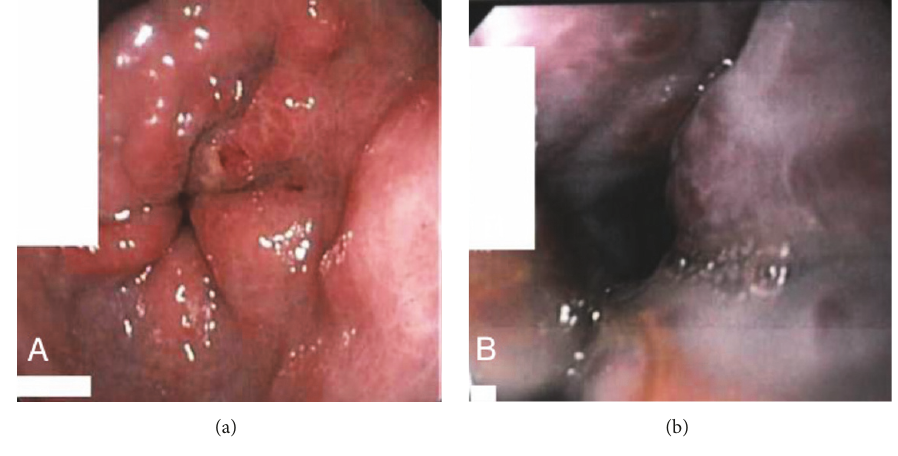
Figure 1: Endoscopy images showing large esophageal varices.